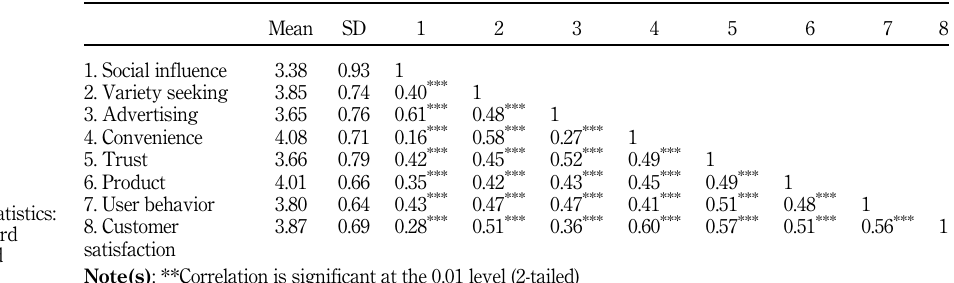
means, standard deviations and